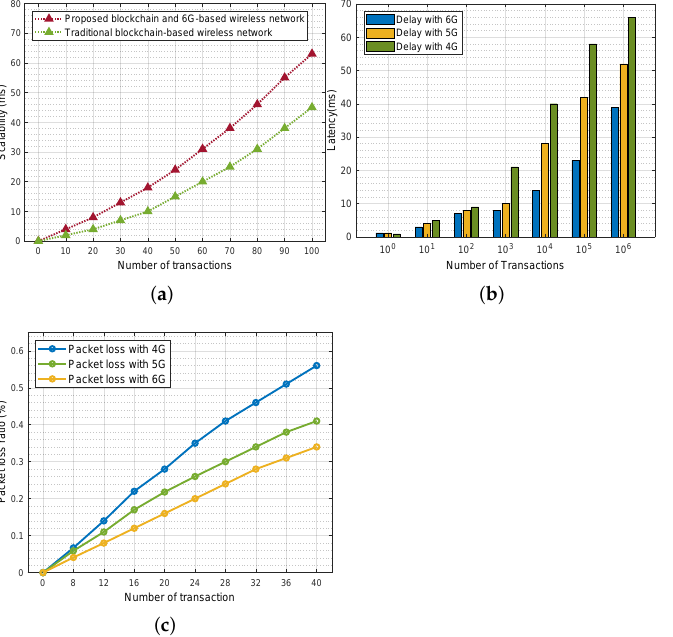
Figure 9. Result analysis of the proposed architecture. ( a ) Scalability comparison. ( b ) Latency comparison. ( c ) Packet-loss ratio